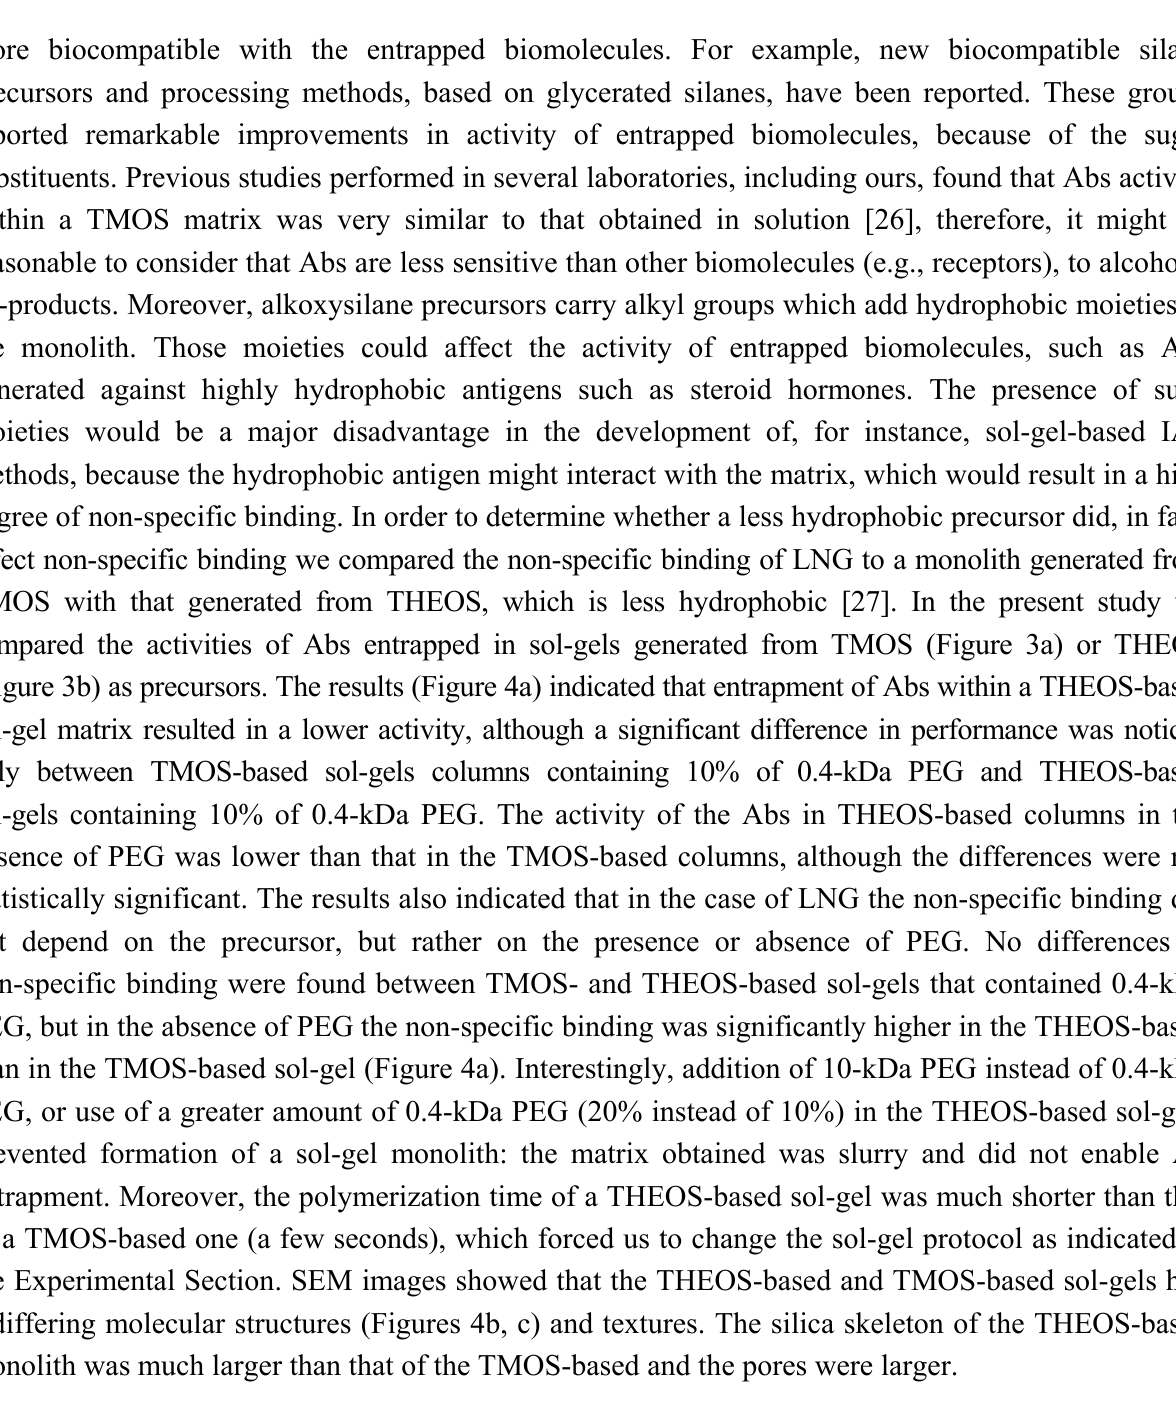
Figure 3. Structures of the sol-gel precursors: ( A ) TMOS; ( B )